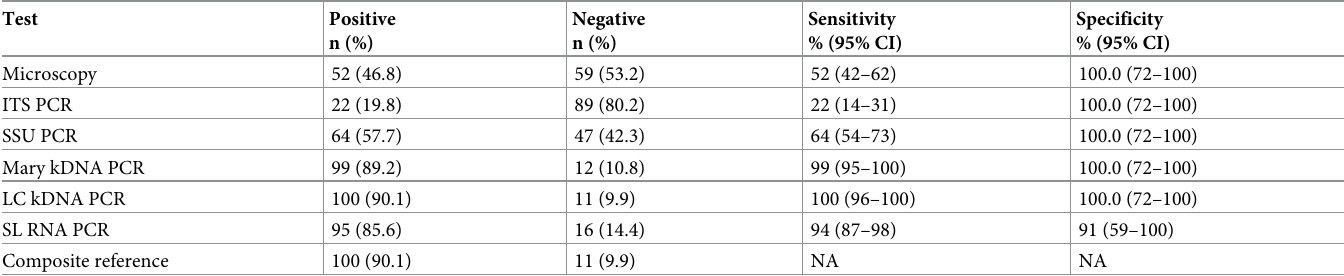
Table 1. Overview of index tests with the number of positive and negative samples, and sensitivity and specificity compared to the composite reference (any two tests